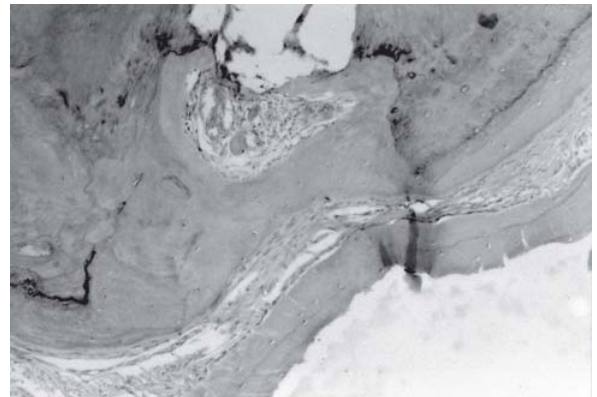
FIGURE 3- Group II – Calcium hydroxide – Newly formed cement providing a partial biological closure and a completely organized periodontal ligament. H.E., TABLE 2- Means of the scores achieved for the different histomorphological events considered for the 4 study groups